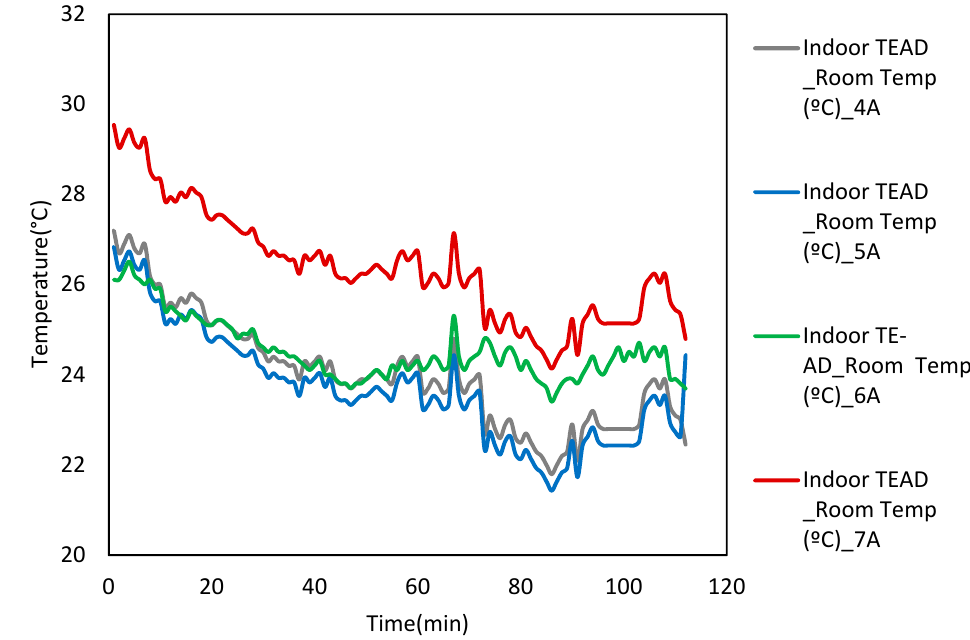
Figure 3. Changes in indoor and outdoor temperatures at different study power inputs.